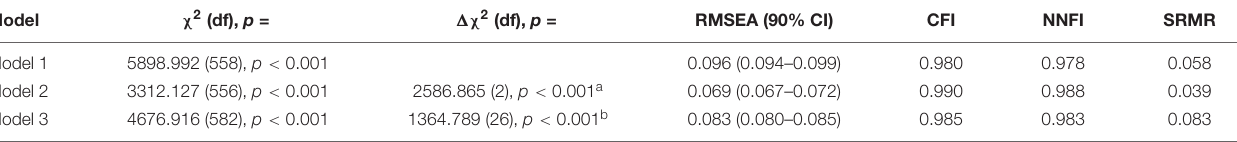
TABLE 2 | Model fitting indices for first-order and second-order factor modeling in the pooled sample, n = 1032.